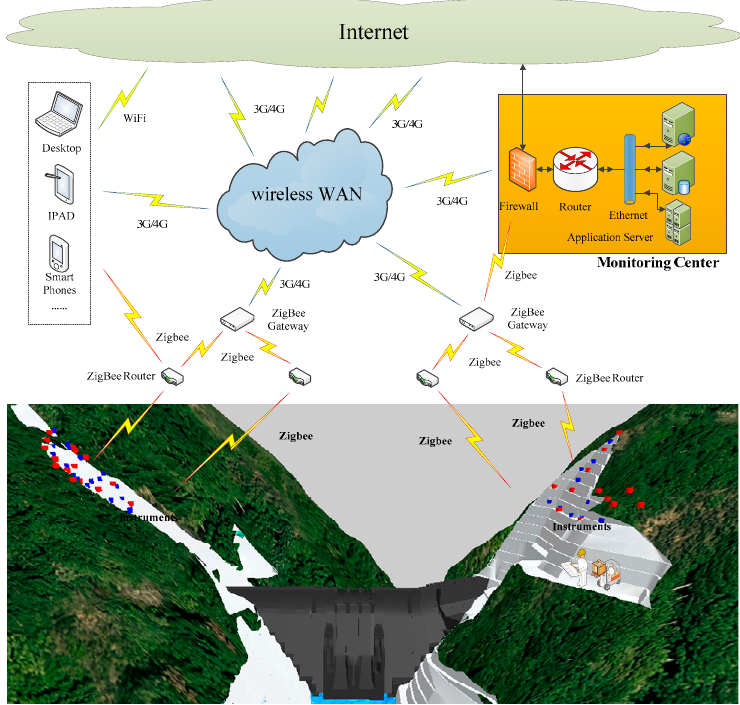
Figure 3. Schematic view of the structural health monitoring system. (WAN means Wide Area Network).